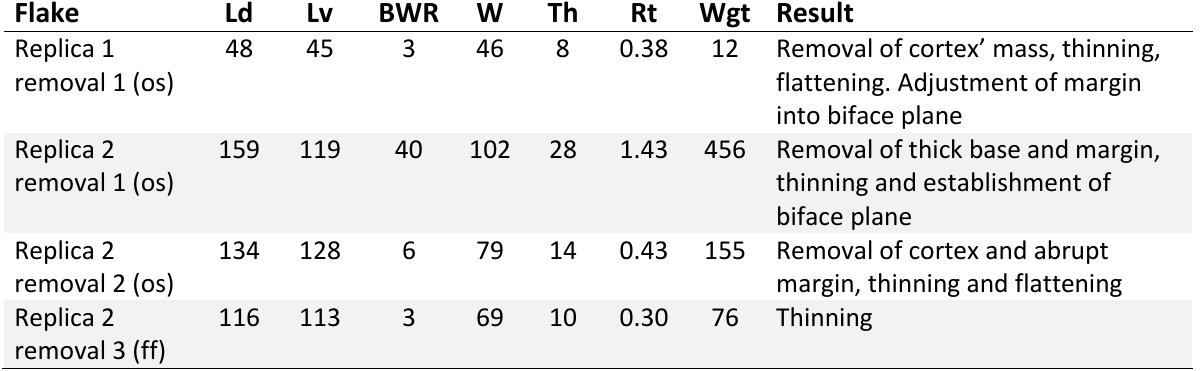
Table 2. Flake dimensions. Abbreviations: Ld = dorsal length; Lv = ventral length; BWR = biface width reduction (Ld-Lv); W = width Th = thickness; Rt = relative thinning (BWR/Th); Wgt =